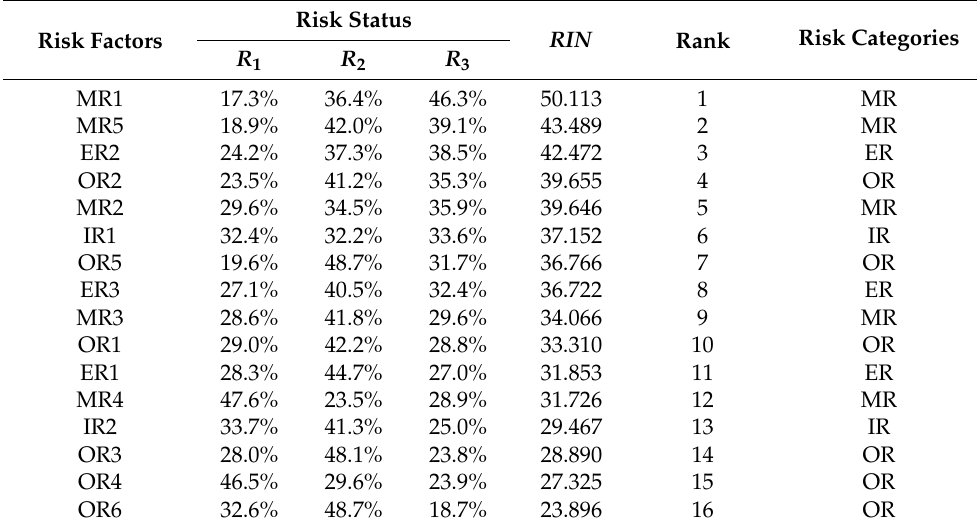
Table 5. Quantization and prioritization of risks in the